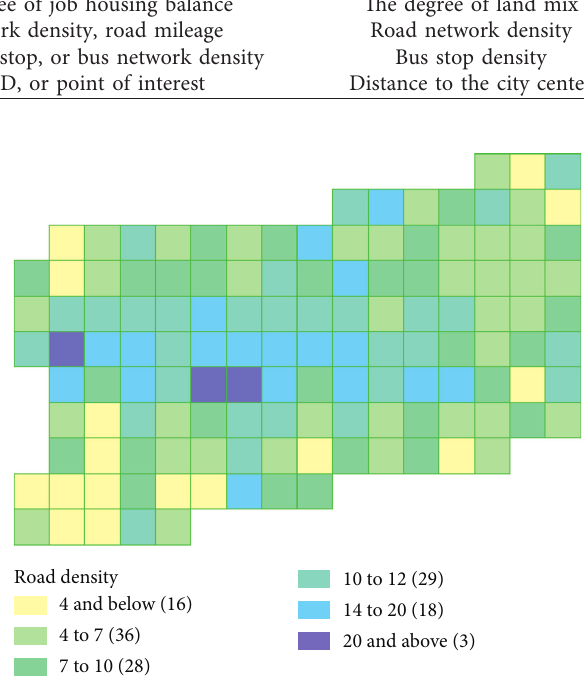
Figure 2: Population density (unit: people per square mile).